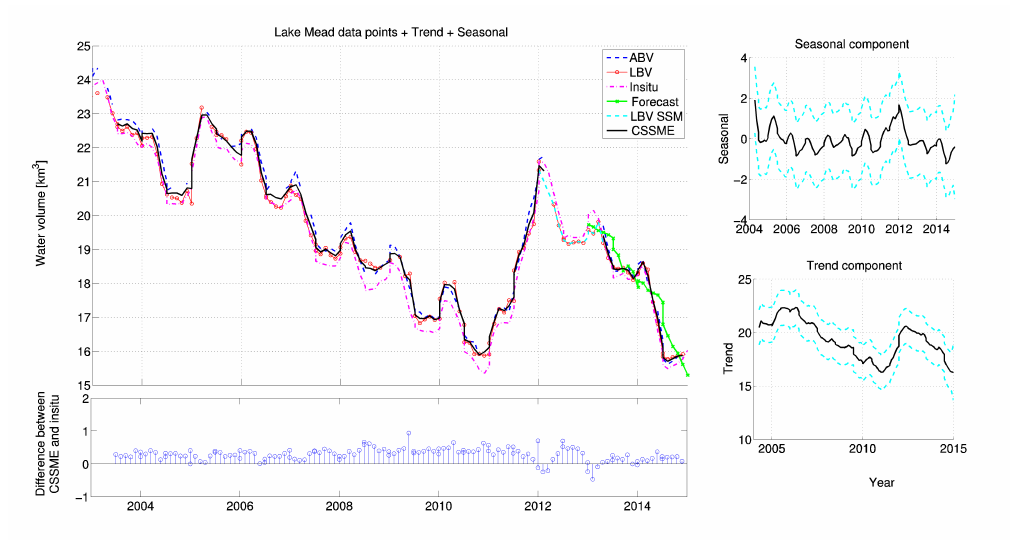
Figure 10. Lake Mead SSM analysis. ( Top left ) The combined SSM estimate (CSSME) (magenta line) and the forecast (green line) for 2013 and 2014; ( Bottom left ) difference between CSSME and in situ observations; ( Top right ) estimated seasonal component; ( Bottom right ) estimated trend component. The dashed cyan lines indicate the upper and lower 95% confidence limit.